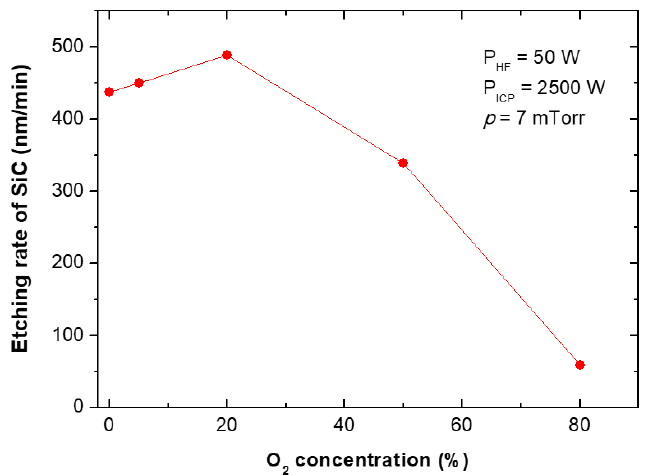
Figure 9. The relationship between oxygen concentration in the SF 6 plasma and SiC etching rate. Fixed parameters are included in the inset.